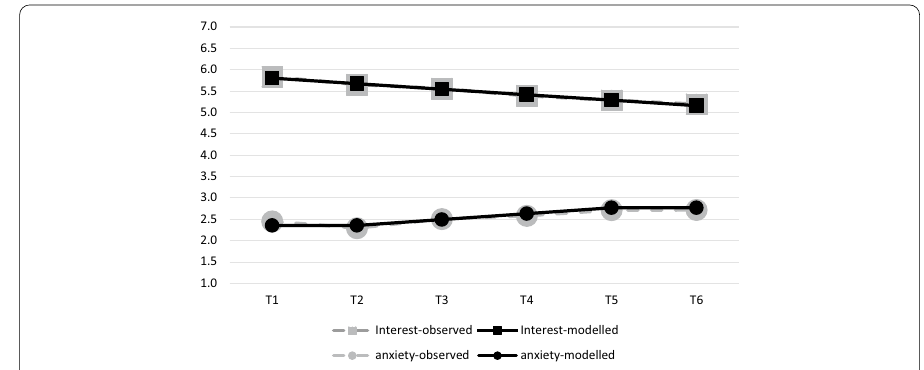
Fig. 1 Latent growth models and observed means for interest and